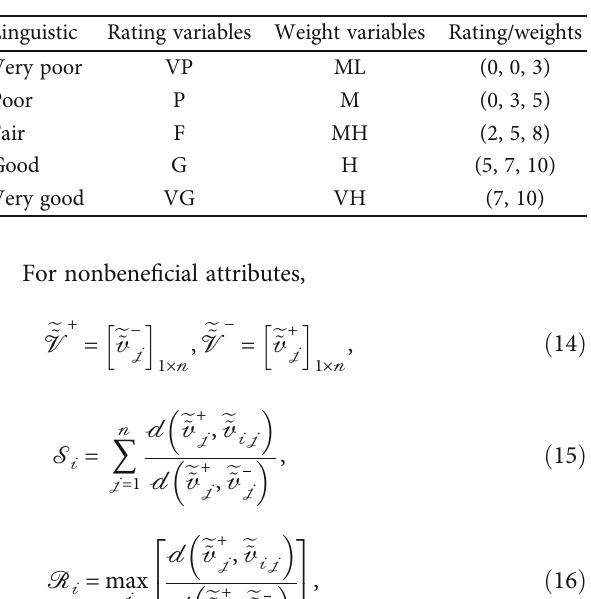
Table 3: The scale for assigning weights for O -parameters and rating and weights for S -parameter ’ s characteristics of FWWB ’ s parameter